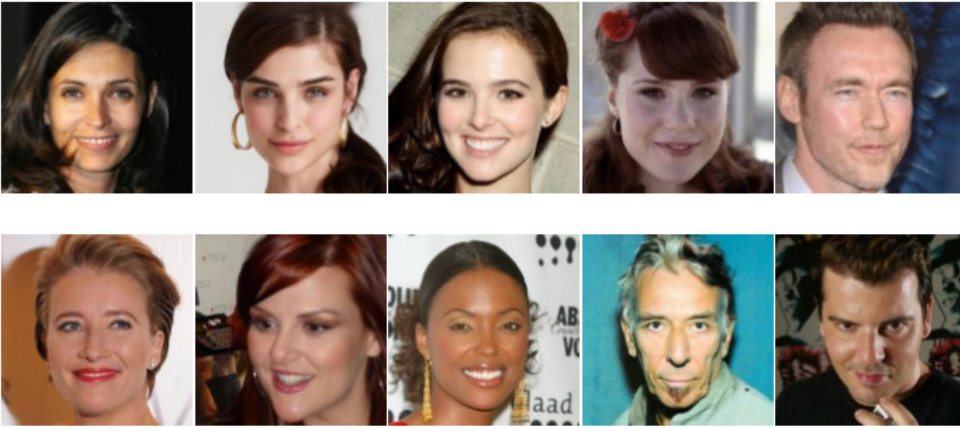
Figure 7. The part of the sample from CelebA and CelebA-HQ Face dataset.